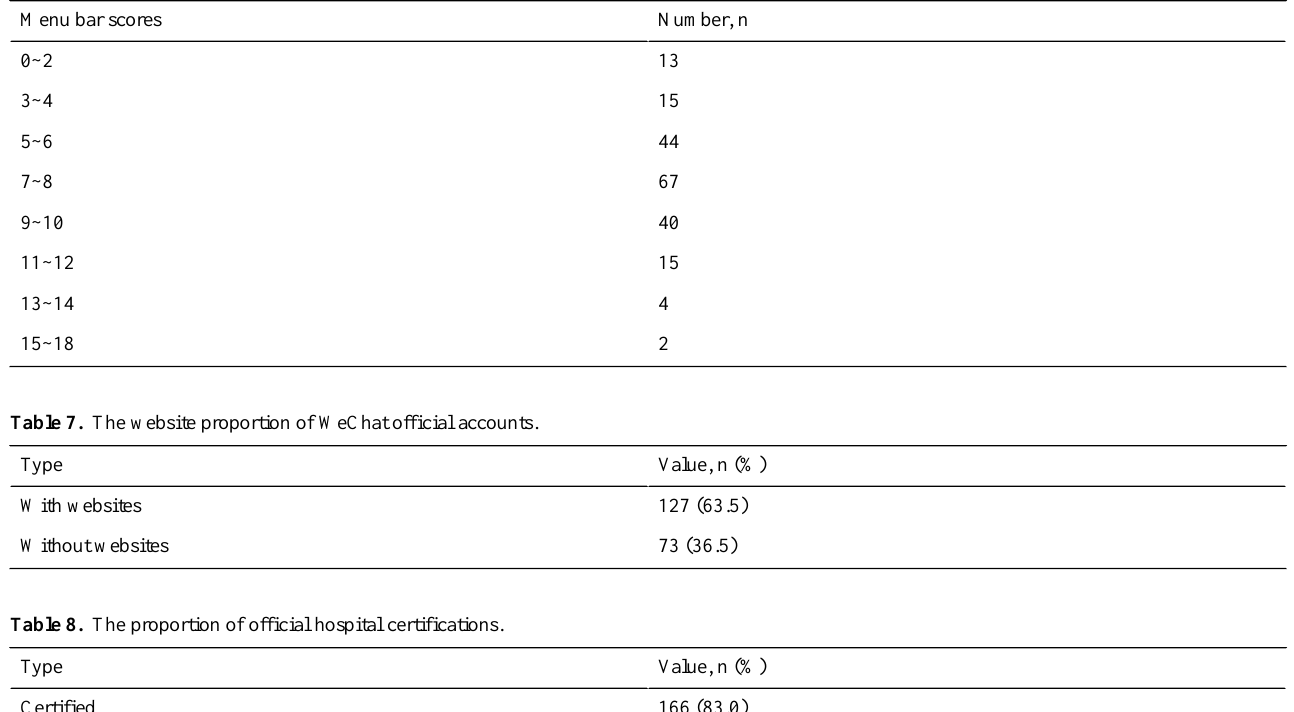
Table 6. Menu bar scores of WeChat official accounts.